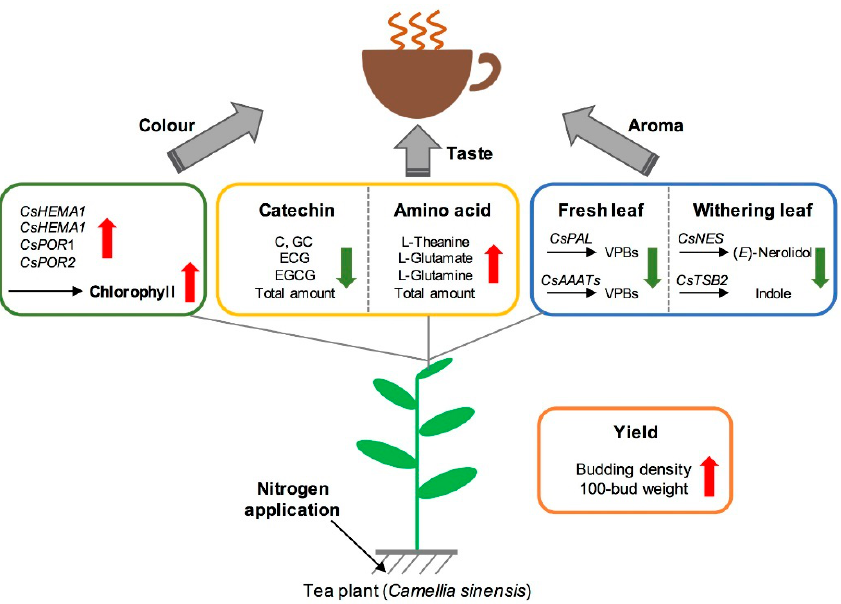
Figure 9. Effects of long-term nitrogen application on tea yield and quality. Red arrows represent the increasing tendency with the increase of nitrogen application, while green arrows represent the opposite tendency. Black arrows represent the nitrogen application. VPBs: volatile phenylpropanoids/benzenoids; EGCG: epigallocatechin gallate; ECG: epicatechin gallate; GC: catechin gallate; C: catechin; HEMA : glutamyl-tRNA reductase ; POR : protochlorophyllide oxidoreductase ; PAL : phenylalanine lyase ; AAAT : aromatic amino acid aminotransferase ; NES : (E)-nerolidol synthase ; TSB : tryptophan synthase β -subunit .